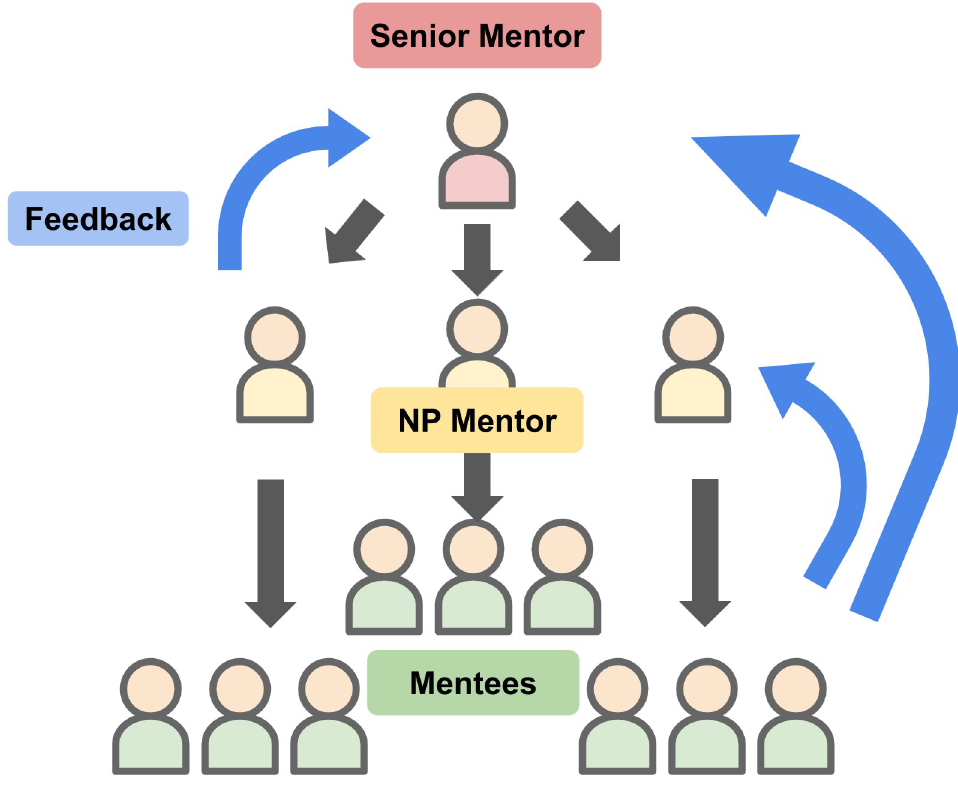
Fig 1. Organisation structure in